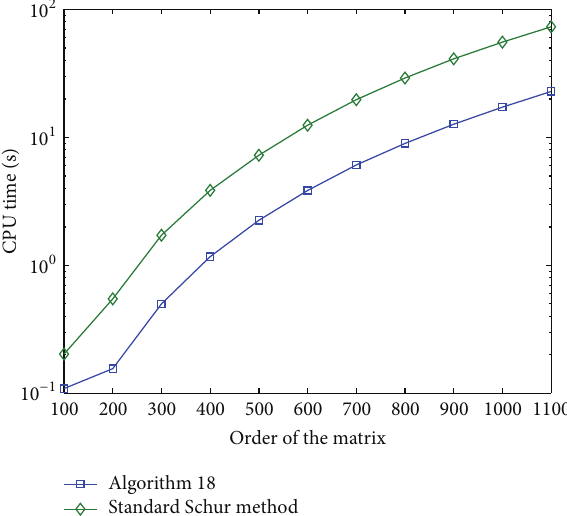
Figure 2: Comparison of the CPU time for Algorithm 18 and the standard Schur method in logarithmic